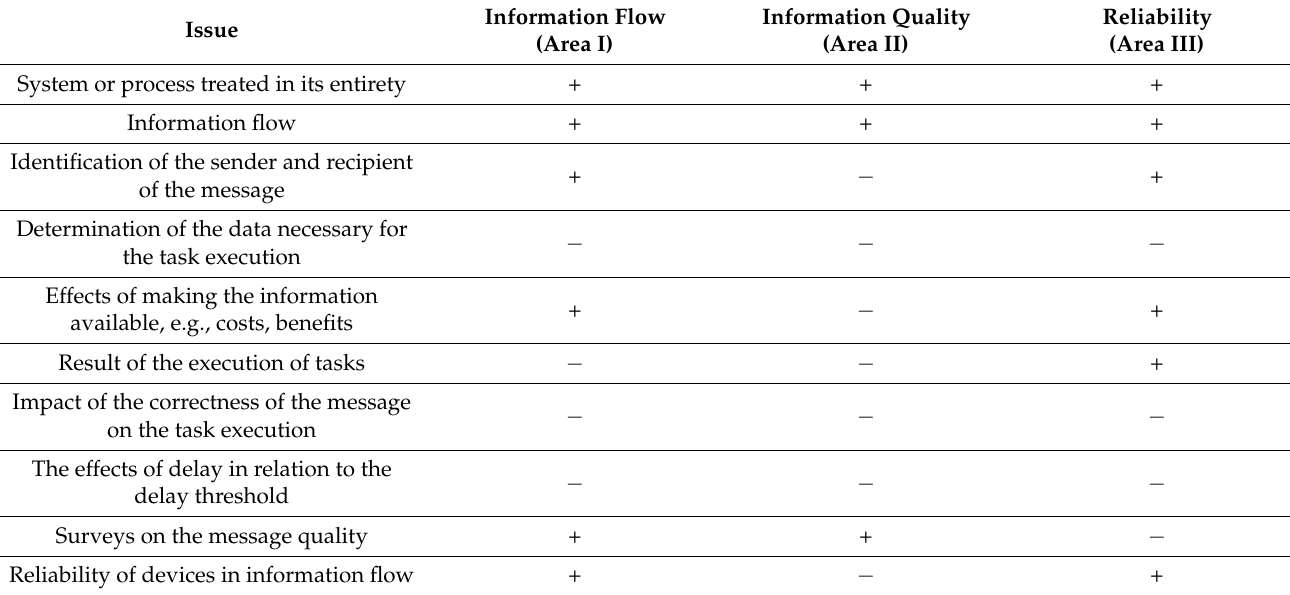
Table 2. Summary of the review in the analysed areas of